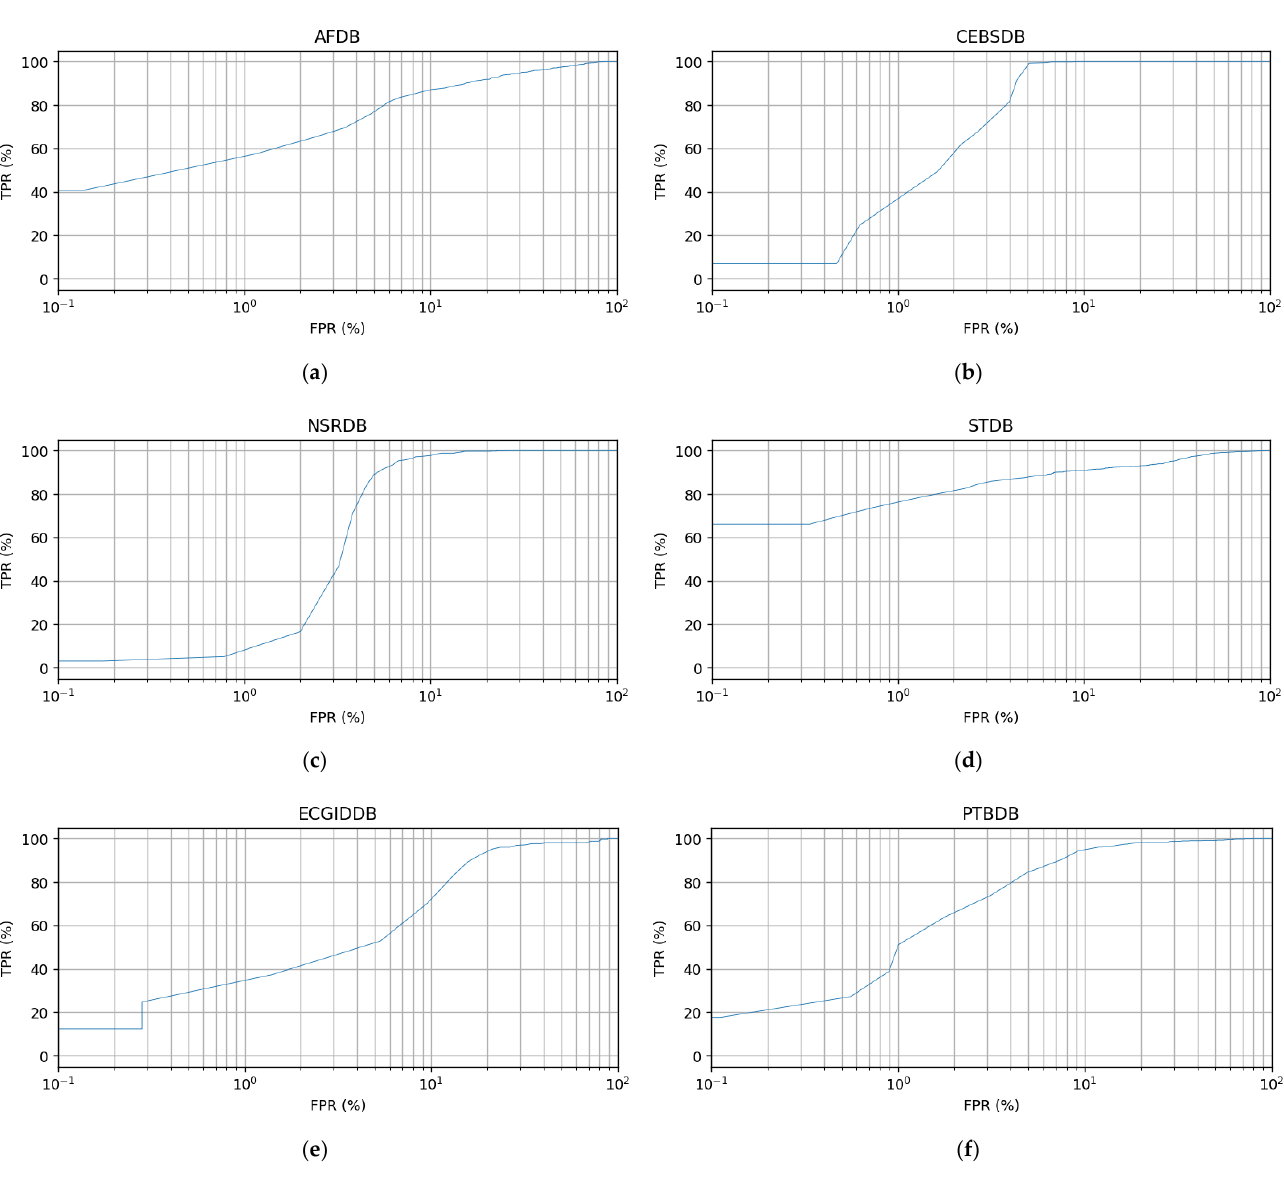
Figure A2. ROC curves are used to evaluate the scope verification performance tested over short time separation for: ( a ) AFDB, ( b ) CEBSDB, ( c ) NSRDB, ( d ) STDB, ( e ) ECGIDDB, ( f ) PTBDB.